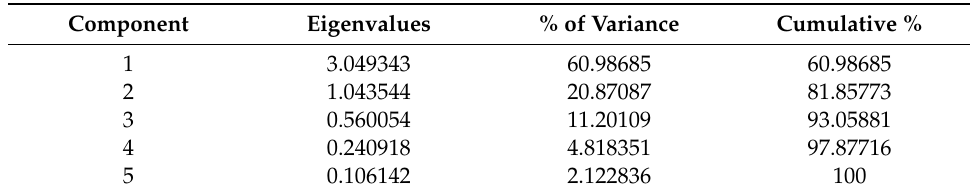
Table 2. Performance of principal component analysis (PCA) on well log data of the southern basin of the South Yellow Sea.